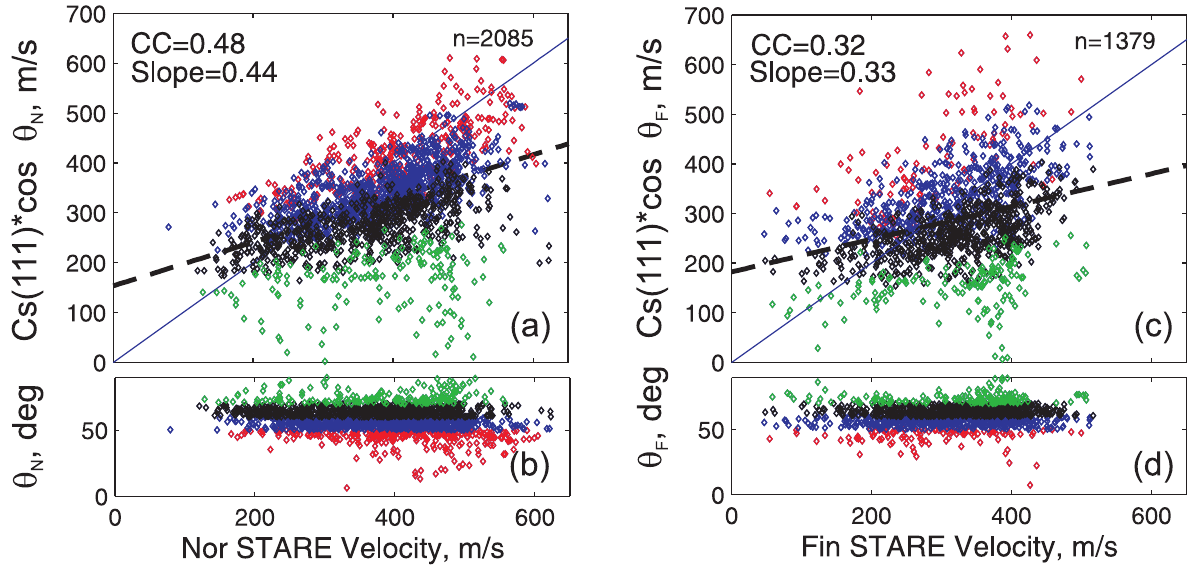
Fig. 4. The same as in Fig. 1 but for the entire data set of 8 (5) events for the Norway (Finland) radar. Coloring is made according to 10-degree bin of the flow angle of